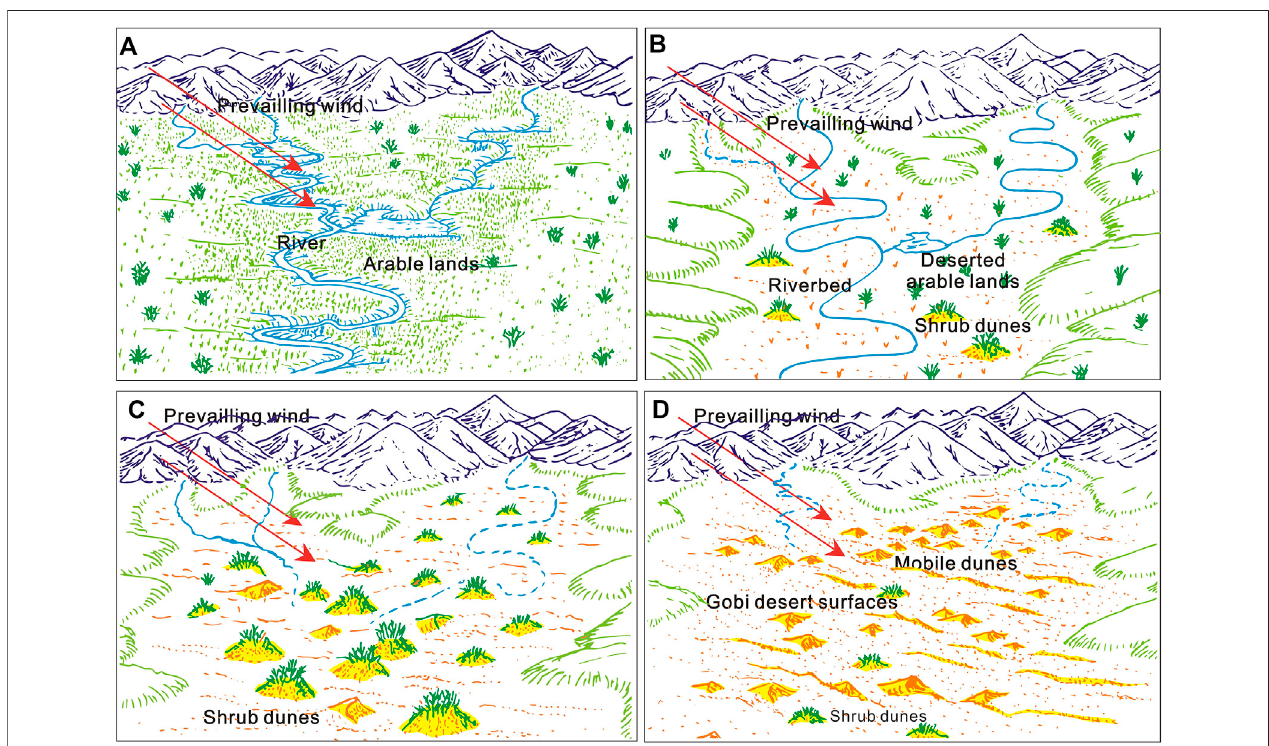
FIGURE 8 | Formation and evolution of shrub dunes in the Hexi Corridor and neighboring areas (modi fi ed after Wang et al. (2008b)).